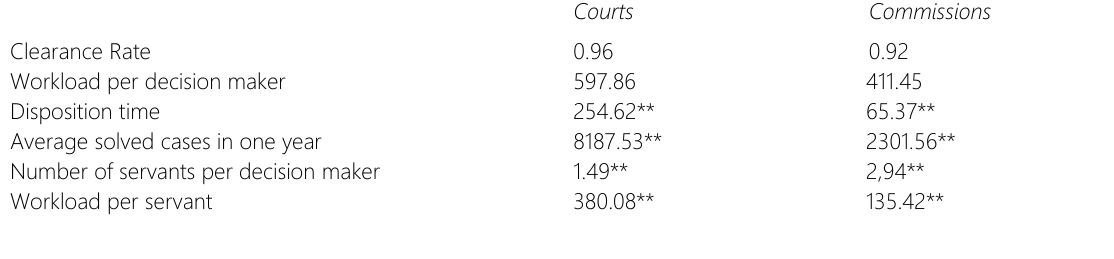
Table 8: Means Comparison of Performance